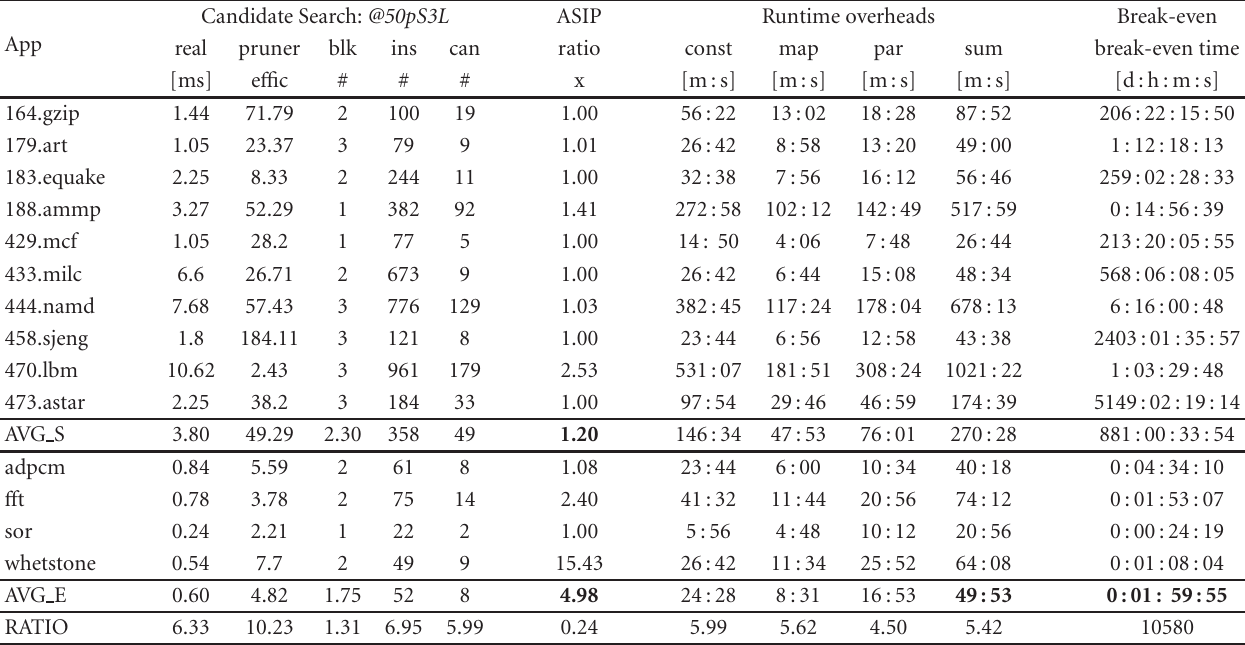
Table 6: The runtime overheads for the